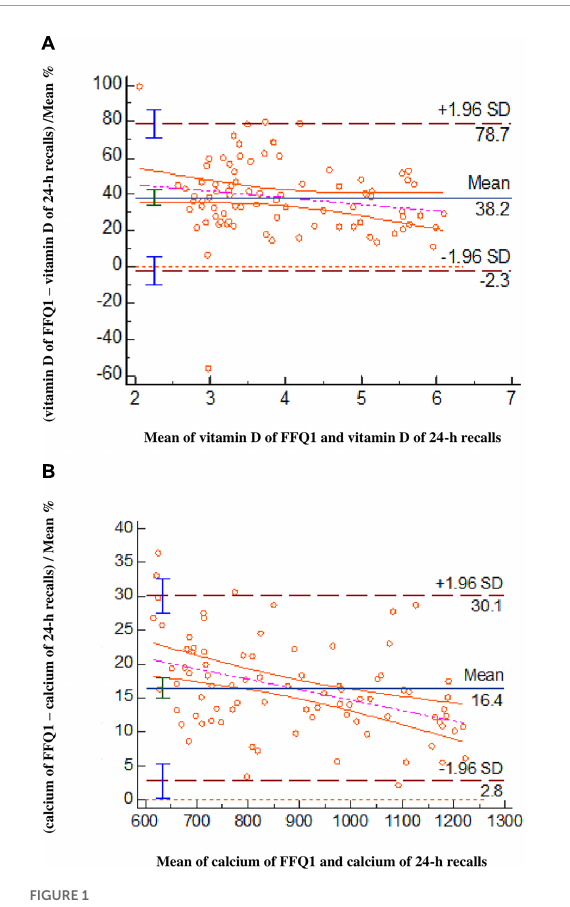
FIGURE1 Bland–Altman plots evaluate the agreement between the FFQ1 and 24-h recalls for vitamin D (A) and calcium (B) intakes ( n =